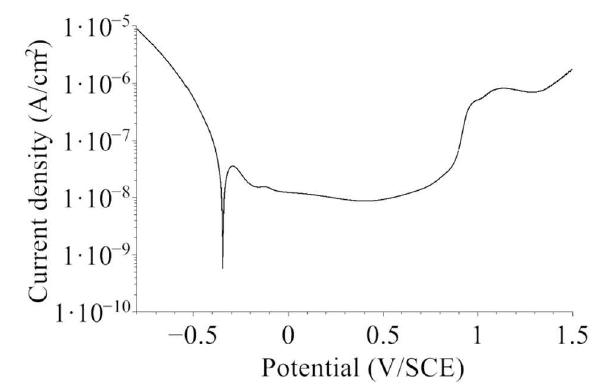
FIGURE 1 | Polarization curve for the native oxide-covered 316L SS sample recorded in 0.05M H 2 SO 4 in the Ar-filled glove box after initial stabilization at open circuit potential for 30min (dU/dt = 5 mV/s).